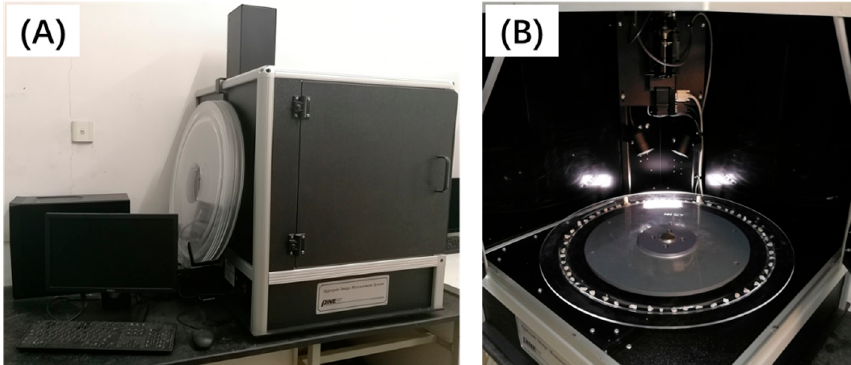
Figure 4. Aggregate image measurement system ( A ), and the tested coarse aggregate placed on tray ( B ).